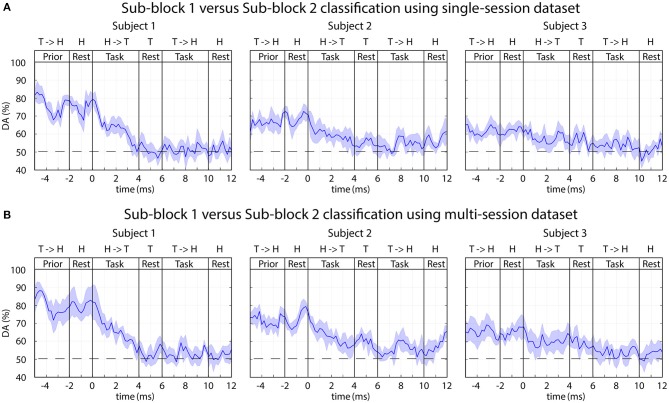
FBCSP: time-varying DA comparing task performance in sub-blocks 1 vs. sub-block 2. The 2-class DA presented in this figure was calculated from single-session (A) and multi-session (B) based datasets comparing sub-blocks with (sub-block 1) and without (sub-block 2) displaying the expected movements. The horizontal dashed lined indicates the chance level (50% for 2-class classification).